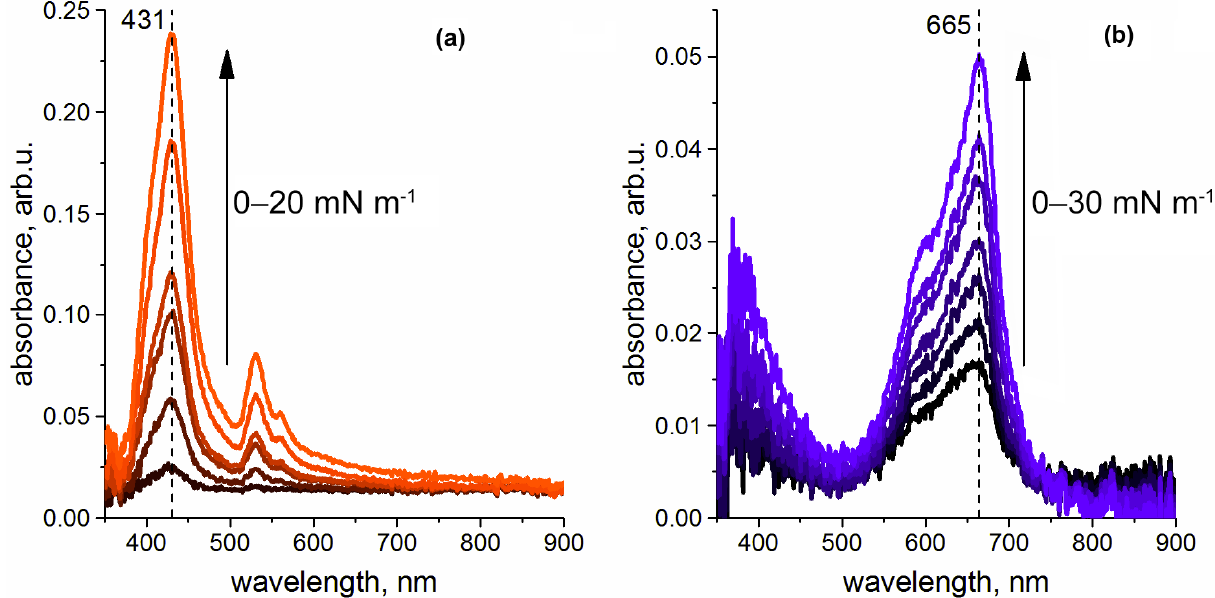
Figure 6. Evolution of the UV-vis spectra of the ( a ) NiTPP and ( b ) CRPcRu(pyz) 2 individual monolayers. Arrow on both panels denotes the direction of the spectral changes upon compression with the values of surface pressure denoted. Note a vertical dashed lane on panel ( a ) showing that the NiTPP Soret band ca. 431 nm does not shift during lateral compression in the individual monolayer.